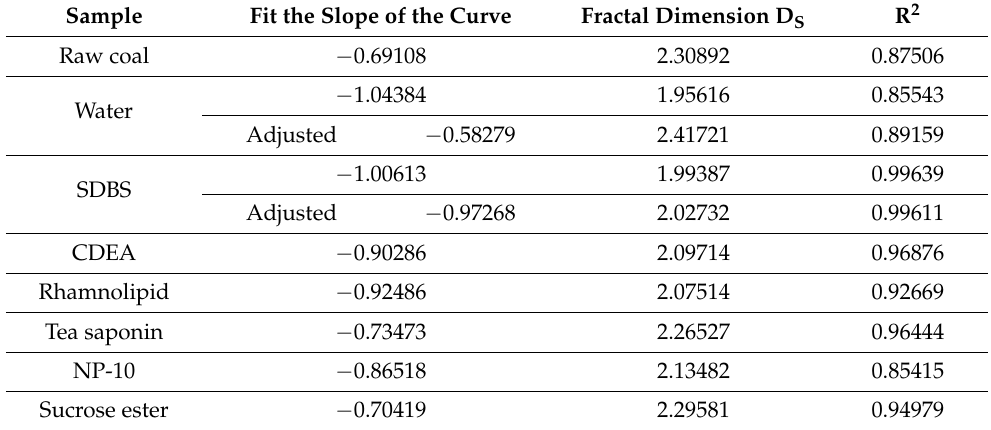
Table 8. Calculation results of fractal dimensions of raw coal and modified coal microscopic surfaces.